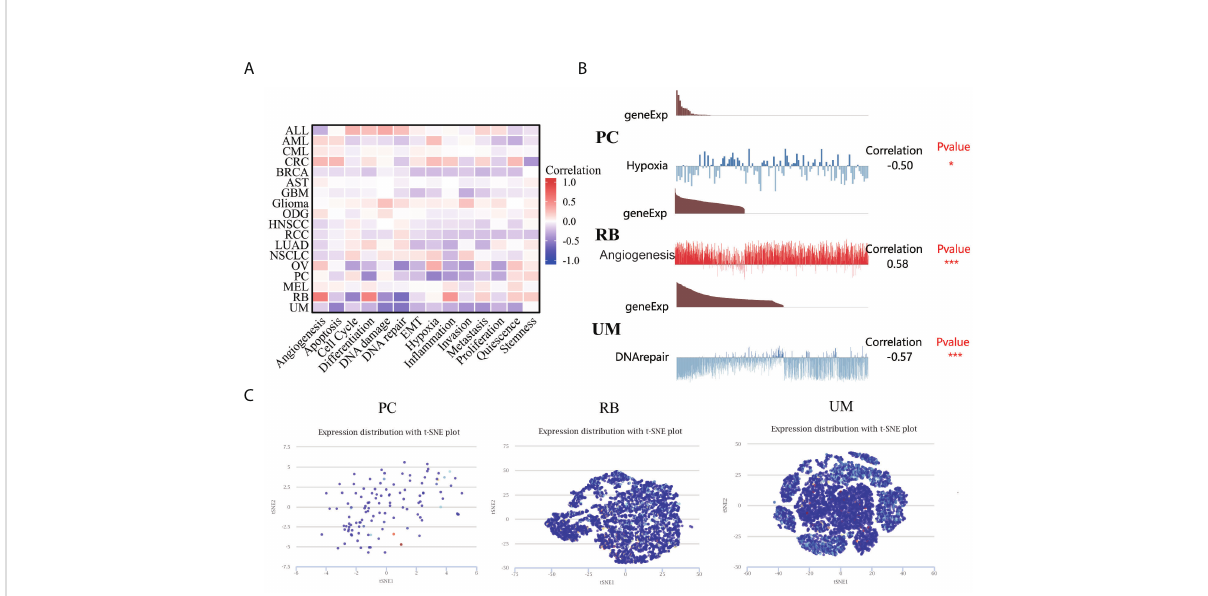
FIGURE 8 The expression levels of LIAS at a single-cell sequence level. (A, B) The CancerSEA tool displayed the relationship between LIAS expression and different functional statuses across pan-cancer. (C) The t-SNE diagrams portrayed the distributions of LIAS at single-cell levels from PC, RB, and UM